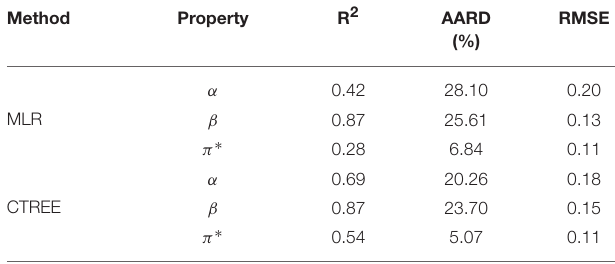
TABLE 2 | Summary statistics for the fitted